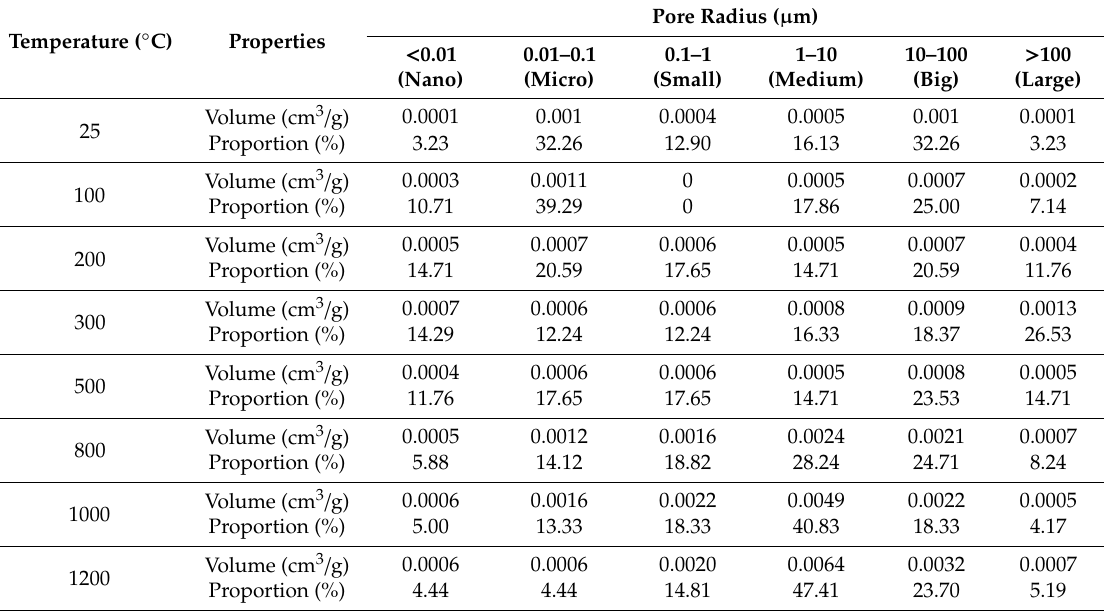
Table 3. Pore volume and proportion with di ff erent size in granite samples after di ff erent heating